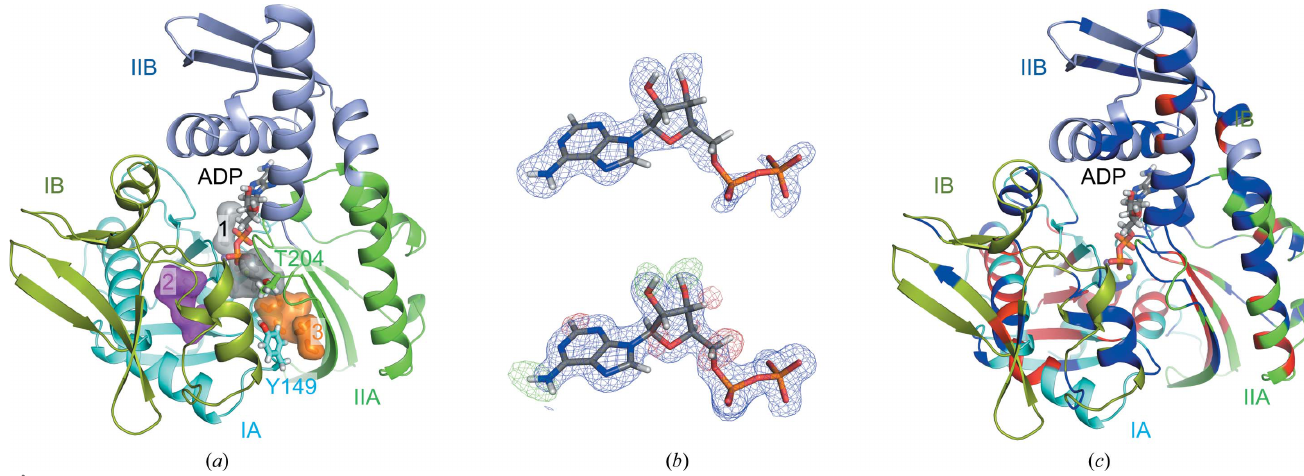
Figure 2 ( a ) Ribbon plot of the overall joint XN structure of the NBD of Hsp72 in complex with ADP (PDB entry 7f4x). Subdomains IA, IB, IIA and IIB are coloured cyan, split pea, green and light blue, respectively. The ADP molecule and the side chains of Thr204 and Tyr149 are shown as stick models. Water clusters 1, 2 and 3 are shown as stick and semi-transparent surface models in grey, magenta and orange, respectively. ( b ) Top: the | F o | (cid:3) | F c | neutron scattering length density map omitting ADP contoured at +4 (cid:2) . Bottom: the | F o | (cid:3) | F c | electron-density map omitting ADP contoured at +4 (cid:2) (blue) and the | F o | (cid:3) | F c | neutron scattering length density map omitting H and D atoms contoured at +3.3 (cid:2) (green) and (cid:3) 3.3 (cid:2) (red). ( c ) The H/D-exchanged and unexchanged regions are projected in the ribbon model. The H/D-exchanged and unexchanged regions are coloured blue and red, respectively.